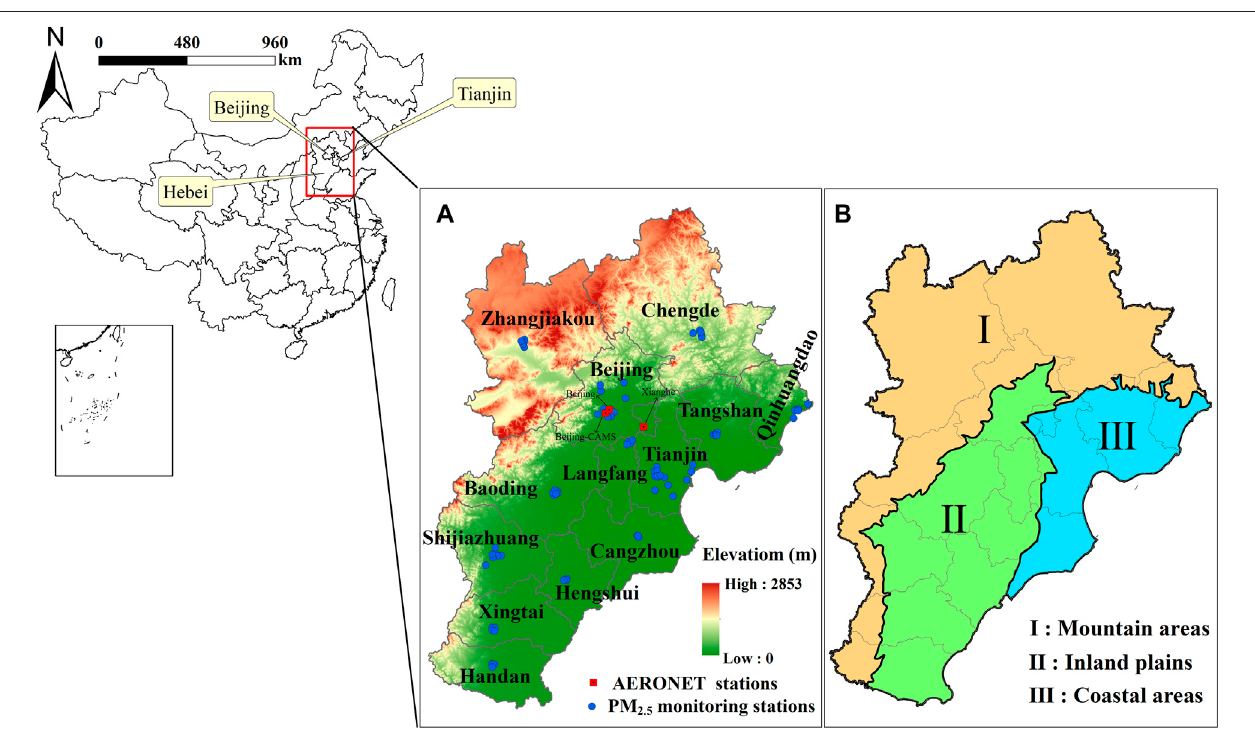
FIGURE 1 | Study area with 80 monitoring stations in the Beijing – Tianjin – Hebei region (A) and sub-areas (B) divided by terrain.